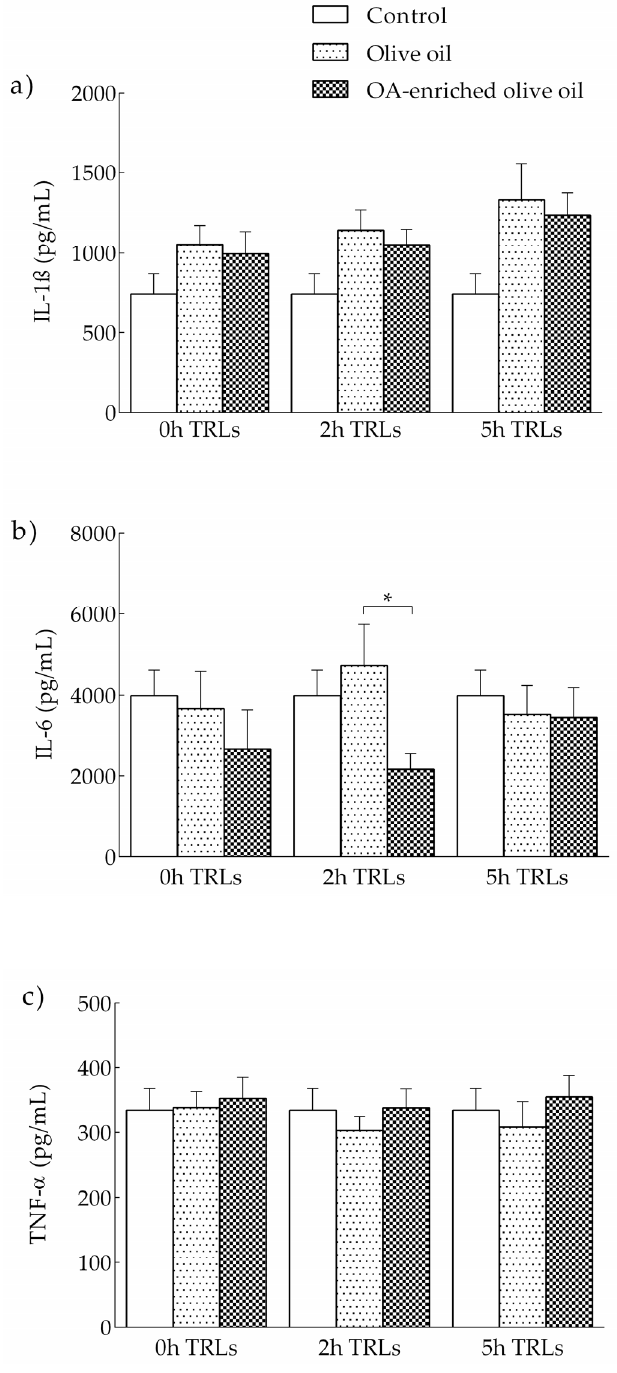
Figure 3. TRL production of proinflammatory cytokines by THP-1 macrophages incubated with TRLs obtained from healthy adolescents before, and at 2 and 5 h after the intake an OA-enriched olive oil or non-functional olive oil. Control cells incubated with PBS. ( a ) IL-1 β ; ( b ) IL-6; ( c ) TNF- α . * p < 0.05.